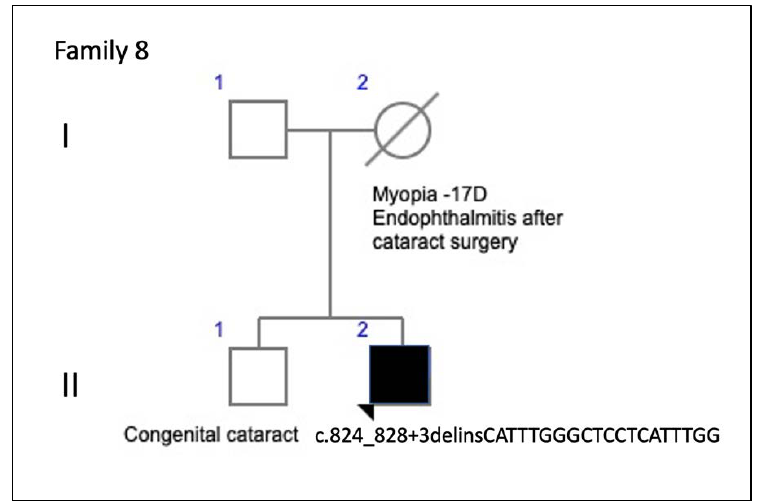
Figure 18. The family 8 pedigree of an apparently isolated case, although the deceased mother had an ocular pathology.